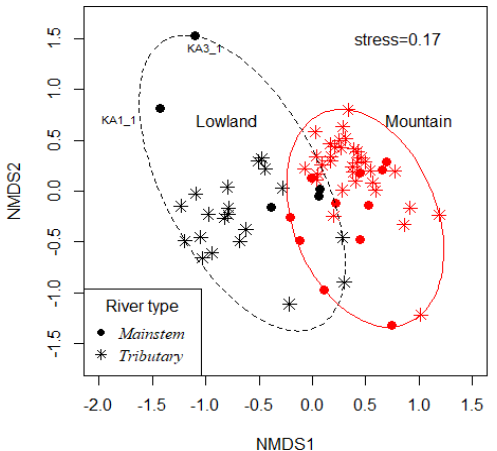
Figure 6. Non-metric multidimensional scaling (NMDS) plot based on benthic macroinvertebrate assemblages for different physiographical zones (High Mountain and Mid-Hill merged as “Mountain” and Siwalik and Terai merged as “Lowland”). Color codes indicate physiographical zones while symbols indicate river types: the river’s mainstem and the tributaries. KA3_1 and KA3_2: sample code of a site in the river’s mainstem for pre-monsoon and post-monsoon seasons, respectively, indicating high seasonal variability for the site.